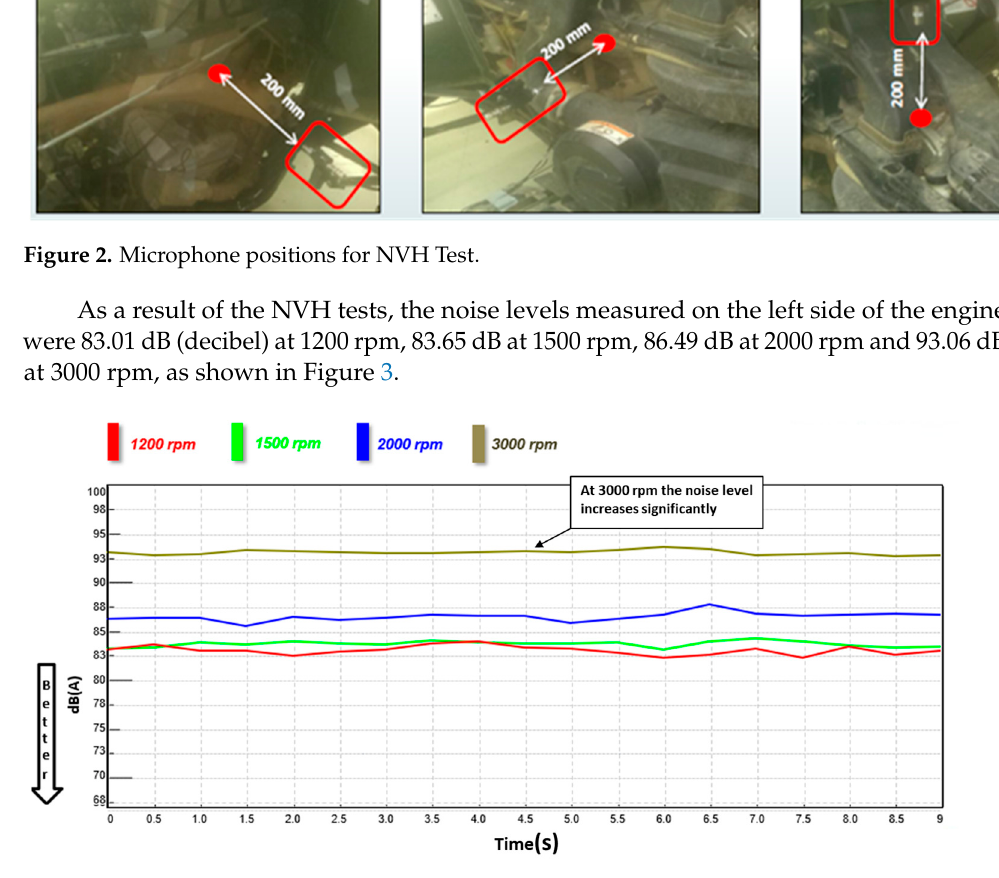
Figure 3. Engine left-side noise level at constant rpm.